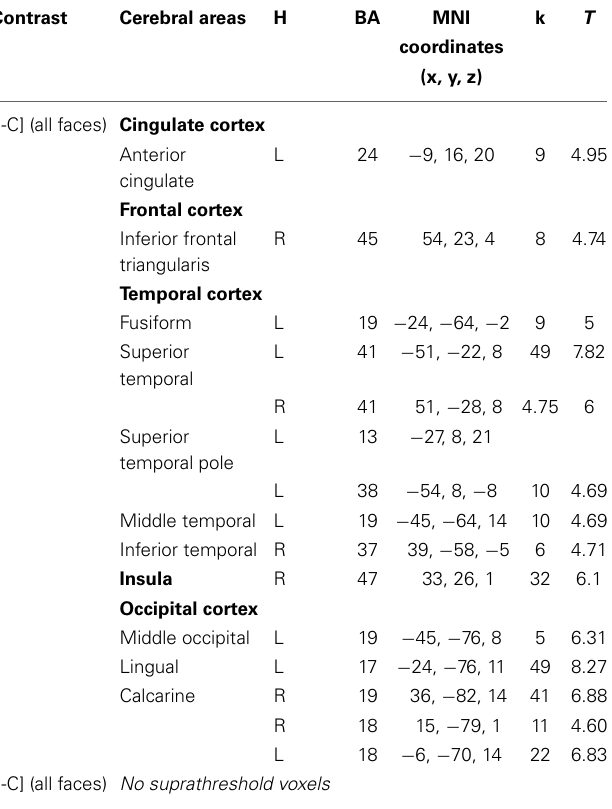
Table 3 | Brain regions activated during the emotional Stroop task using all faces in healthy subjects.